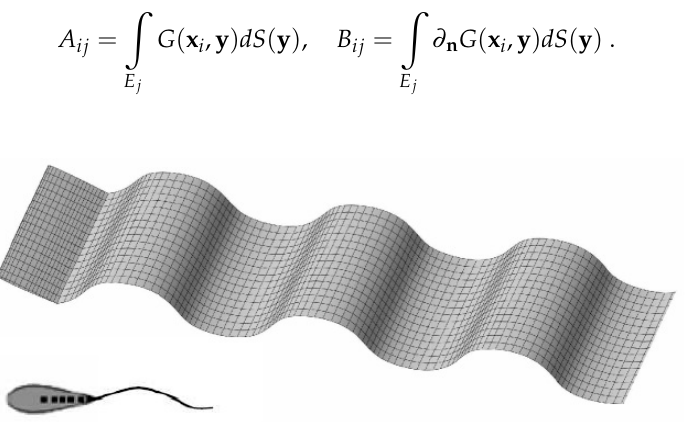
Figure 3. Foil and wake model geometry discretization. The foil and wake boundaries are approximated with bilinear elements. The source and dipole distribution on the foil is considered piecewise constant. The detail shows the wake model geometry in the vicinity of the trailing edge.